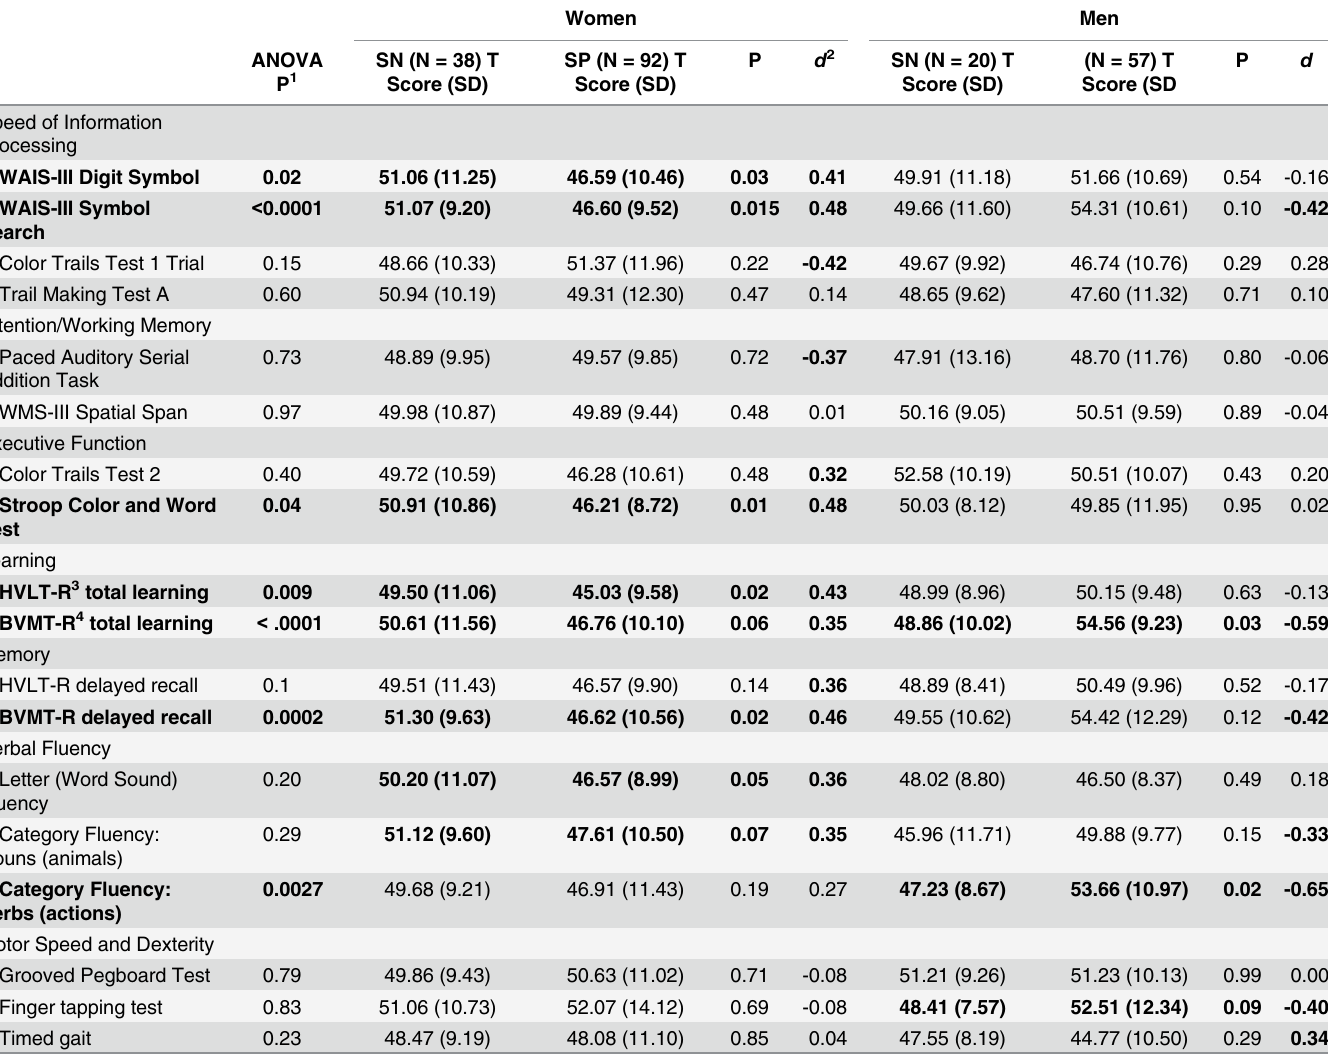
Table 2. Neuropsychological Performance for SN and SP Women and Men.